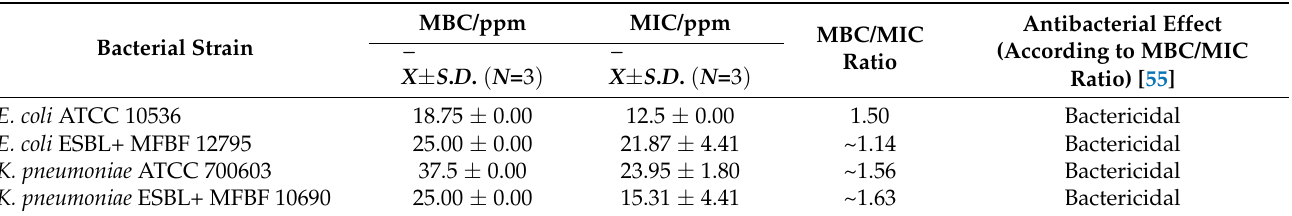
Table 3. MBC and MIC values for colloidal solutions of platinum nanoparticles for the tested bacterial strains of E. coli and K. pneumoniae in M9 minimal salts with 3% glucose solution as a medium. Concentrations are expressed as ppm (i.e., parts per million ), equal to µ g mL − 1 . Values are presented as means ± standard